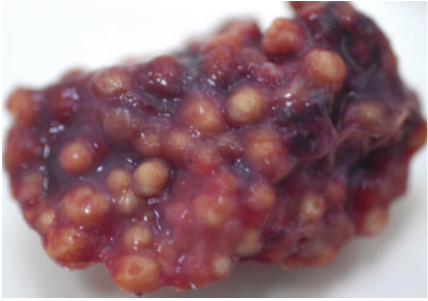
Figure 1: Numerous nodules in the lung of a duck with acute as-